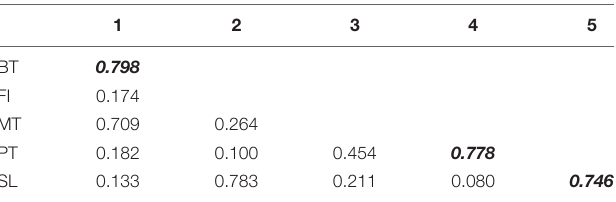
TABLE 3 | Correlation values and Fornell-Larcker criterion.